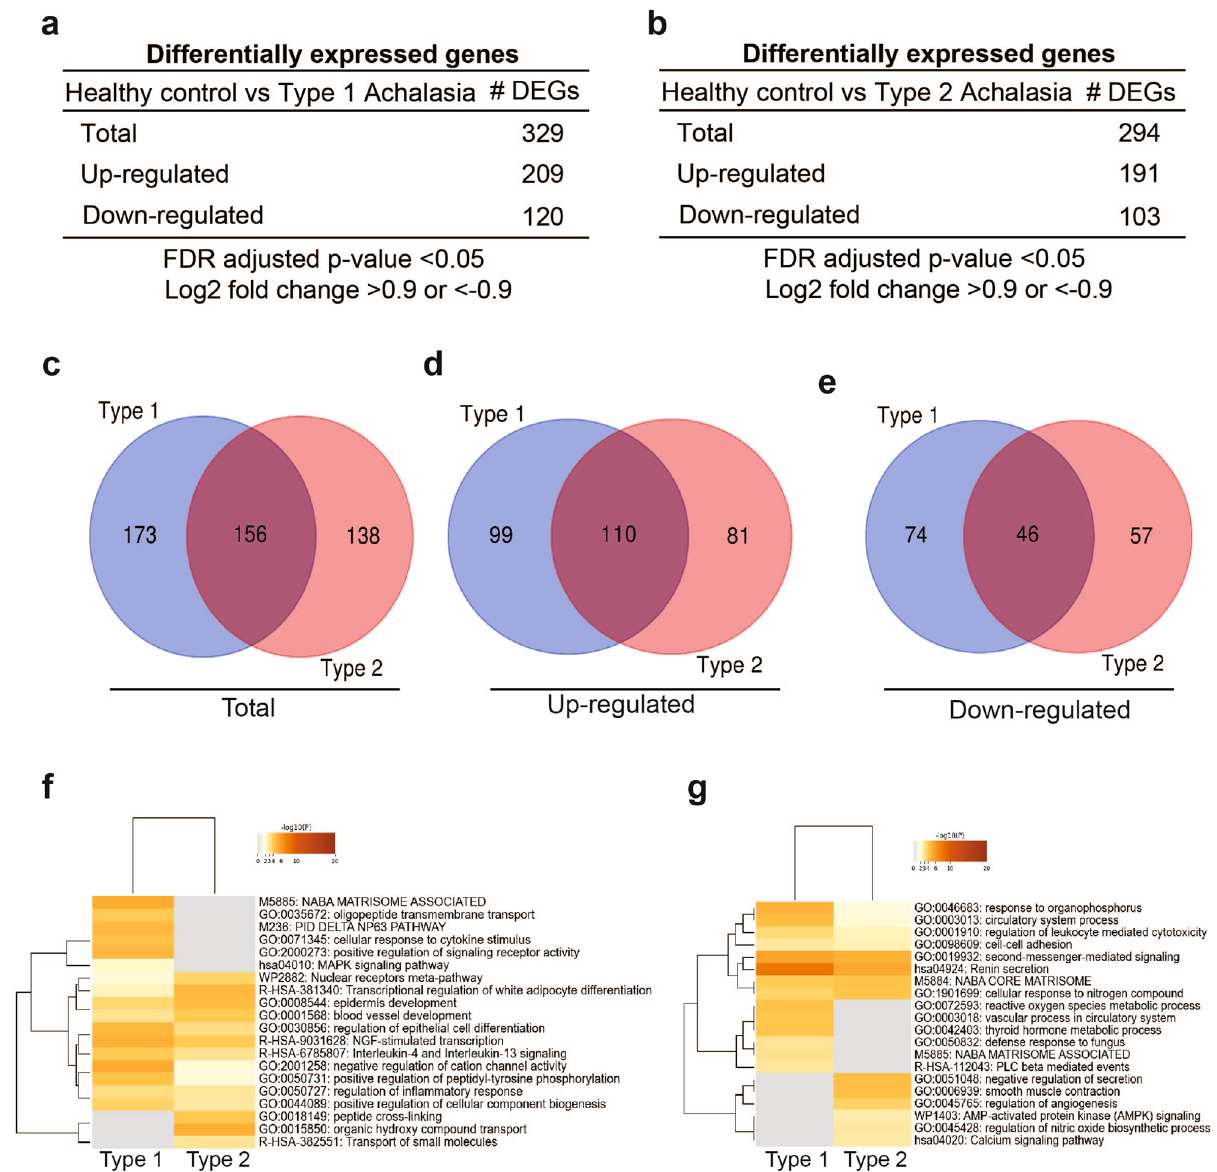
Figure 8. Comparison of differential gene expression analysis in proximal esophageal mucosa of type I and/ or type II achalasia compared to healthy controls. ( a , b ) Differentially expressed genes in type I achalasia ( a ) or type II achalasia ( b ) versus healthy controls were selected based on a log2 fold change of 0.9 and FDR < 0.05. ( c – e ) Venn diagram showing overlap of DEGs in type I and type II achalasia subjects. ( c ) Total DEG is shown. ( d ) Up-regulated DEGs between type I and type II achalasia are illustrated. ( e ) Down-regulated DEGs between type I and type II achalasia are shown. ( f , g ) Gene ontology analysis using Metascape. ( f ) A heatmap of the top up-regulated pathways is shown. ( g ) A heatmap of the top down-regulated pathways is